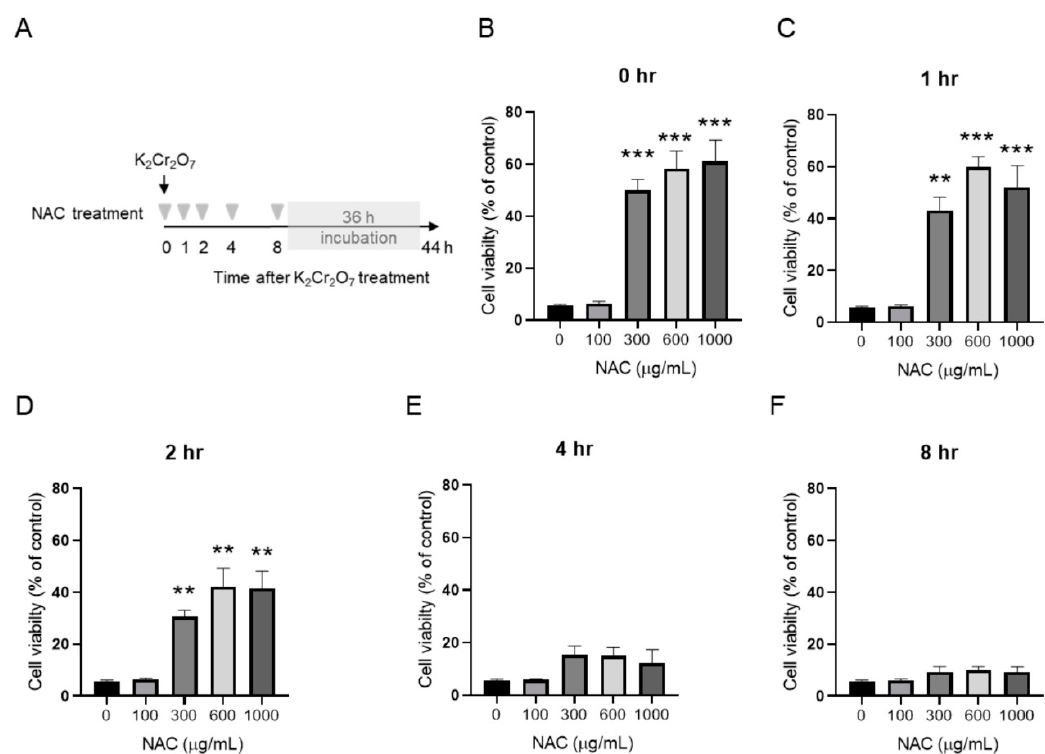
Figure 3. Protective effect of NAC on cell viability of HK-2 cells. ( A ) Scheme of time-delayed NAC treatment. The viability of HK-2 at ( B ) 0 h, ( C ) 1 h, ( D ) 2 h, ( E ) 4 h, and ( F ) 8 h post-treatment with 10 μ M K 2 Cr 2 O 7 is demonstrated. Data are presented as mean ± SD. * P < 0.05, ** P < 0.01, and *** P < 0.001, when compared with 0 g/mL NAC-treated group at each time-point.